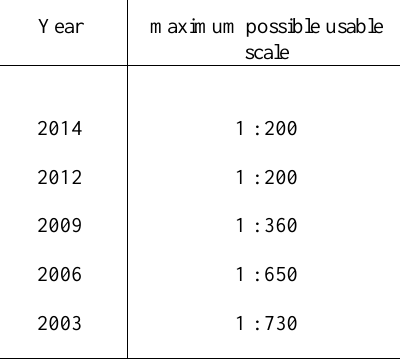
Table 2. maximum possible usable scale in different periods